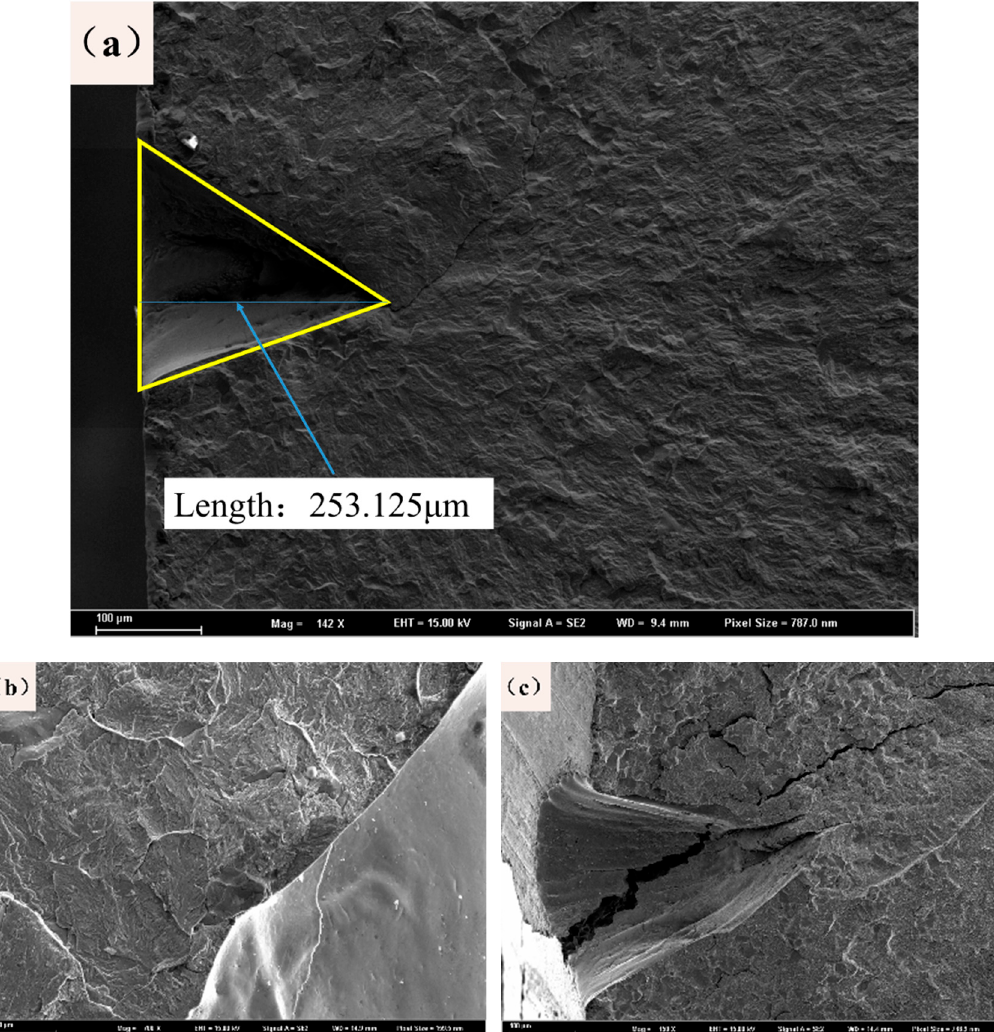
Figure 10. Fracture morphologies near the blind hole: ( a ) blind hole depth measurement graph, ( b ) normal sample morphology, and ( c ) stress concentration of large sample shape.